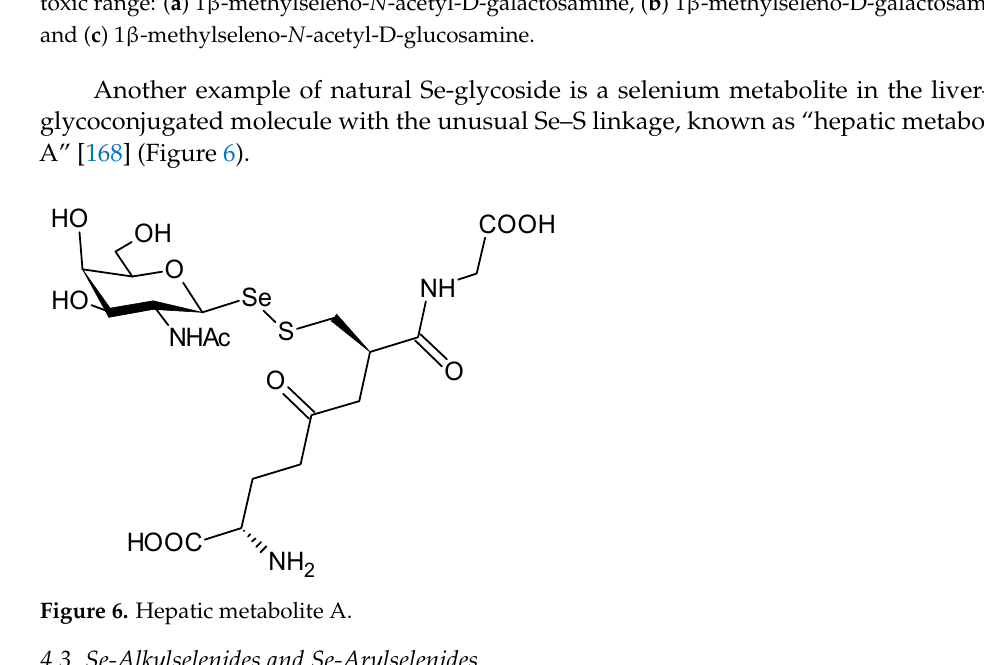
fore can potentially prevent oxidative damage of proteins and lipids [242].